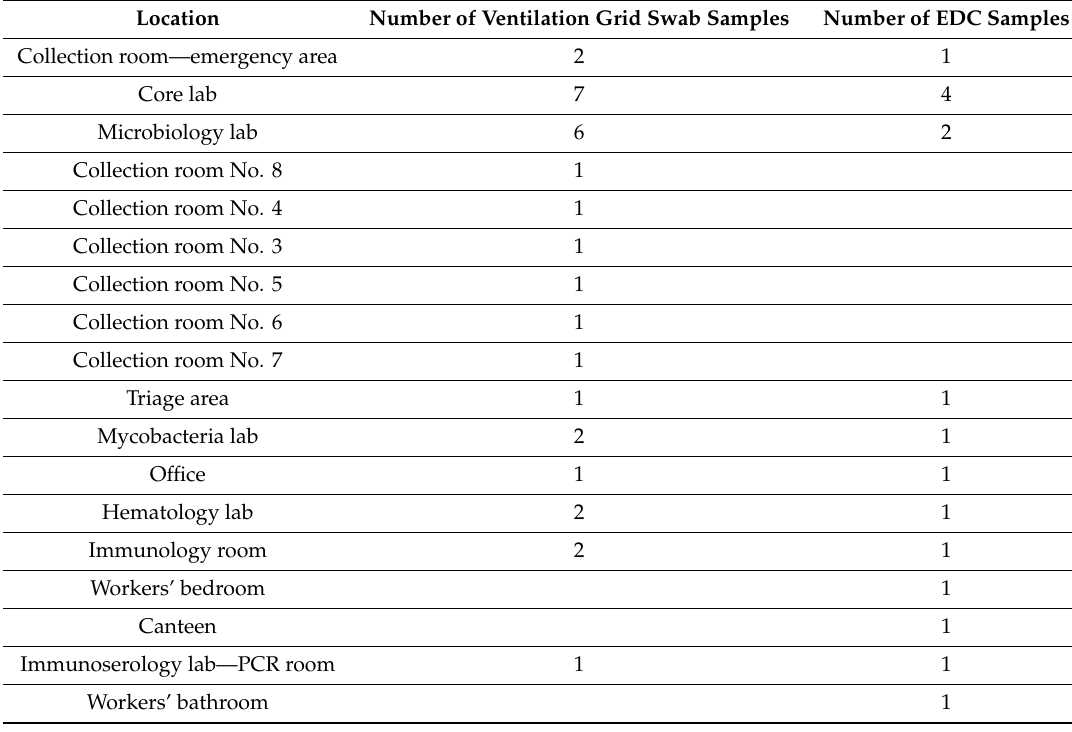
Table 1. Samples collected in each location of the Clinical Pathology